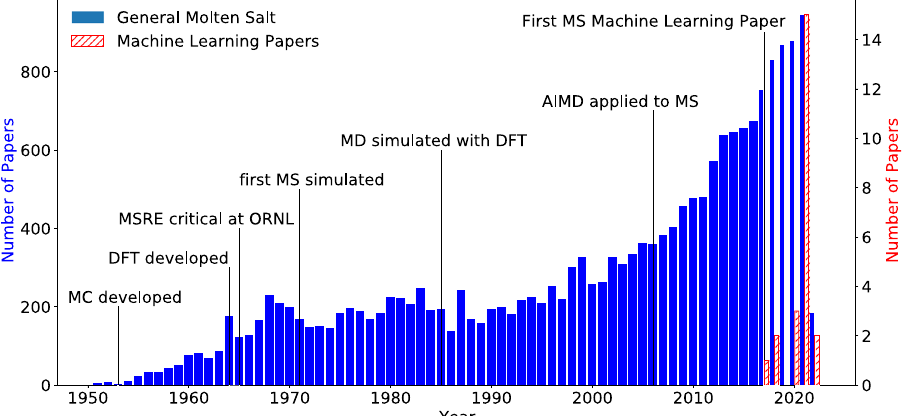
Fig. 4 Timeline of papers published on molten salt reactors per year. Generally relevant papers in blue. Papers that use machine learning and apply it to molten salts are shown proportionately in hatched-red. Important milestones are marked and include: Monte Carlo (MC) being developed, Density Functional Theory (DFT) being developed, the Molten Salt Reactor Experiment (MSRE) going critical at Oak Ridge National Labs, the fi rst molten salt (MS) simulation, Molecular dynamics (MD) begin to be simulated with Density Functional Theory, Ab Initio Molecular Dynamics (AIMD) are applied to molten salts, and machine learning being applied to Molten